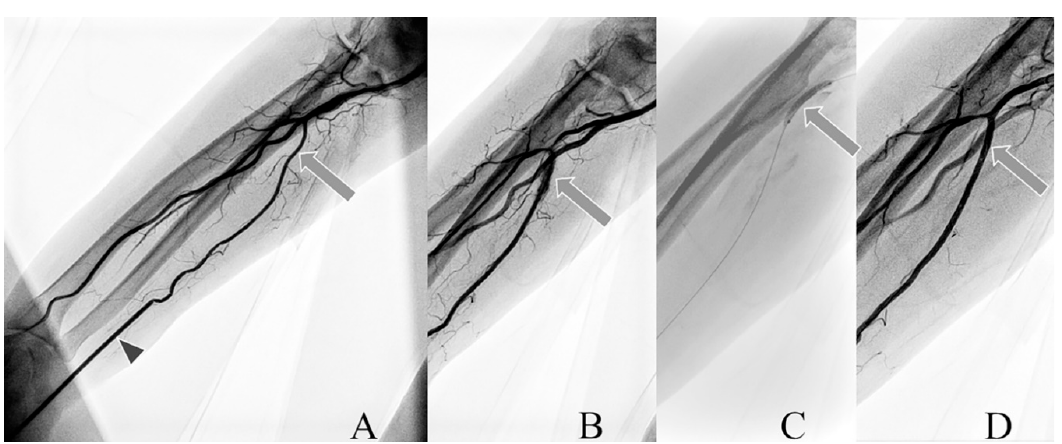
Figure 3. Angiograms of perforated UA. ( A ) vascular sheats (arrowhead), ulnar artery (arrow), ( B ) perforation of the artery (arrow), ( C ) balloon angioplasty (arrow), ( D ) artery without perforation (arrow).